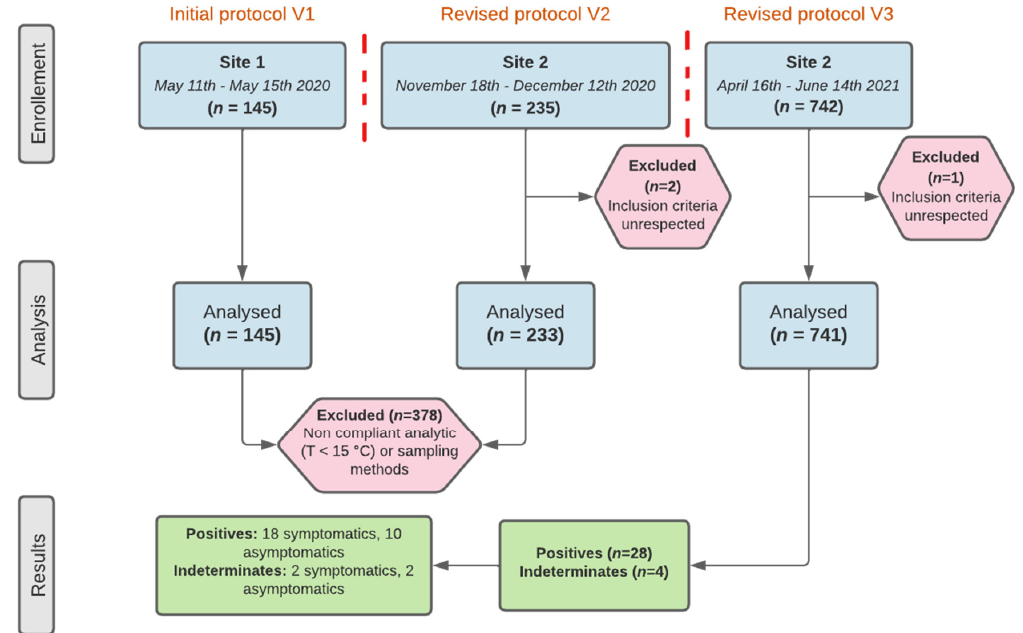
Figure 4. RAPID COVID study results flow chart. The first line of the flow chart shows the number of patients enrolled during the three inclusion periods. The second line shows the number of patients that were included in the analysis and the reasons why some were excluded. The third line shows the number of “positive” or “indeterminate” samples and the proportion of symptomatic patients. The red vertical dotted lines indicate protocol changes.